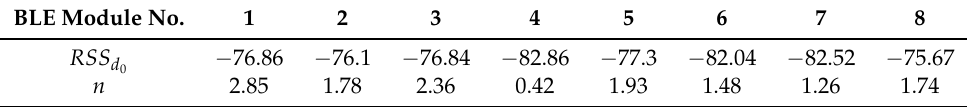
Table 15. The propagation model parameters in the case of the NLoS condition. BLE Module